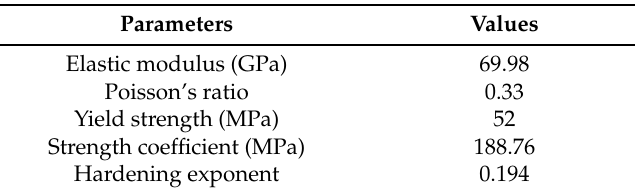
Table 1. Chemical composition of 3A21 ‐ O aluminum alloy. Table 2. Material parameters of 3A21-O aluminum alloy.